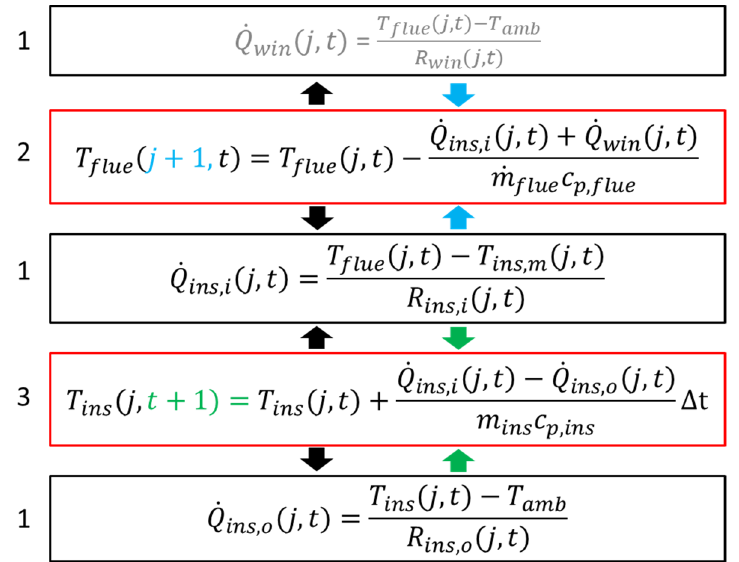
Figure 8. Calculation routine for the flue gas temperature at the combustion chamber outlet.